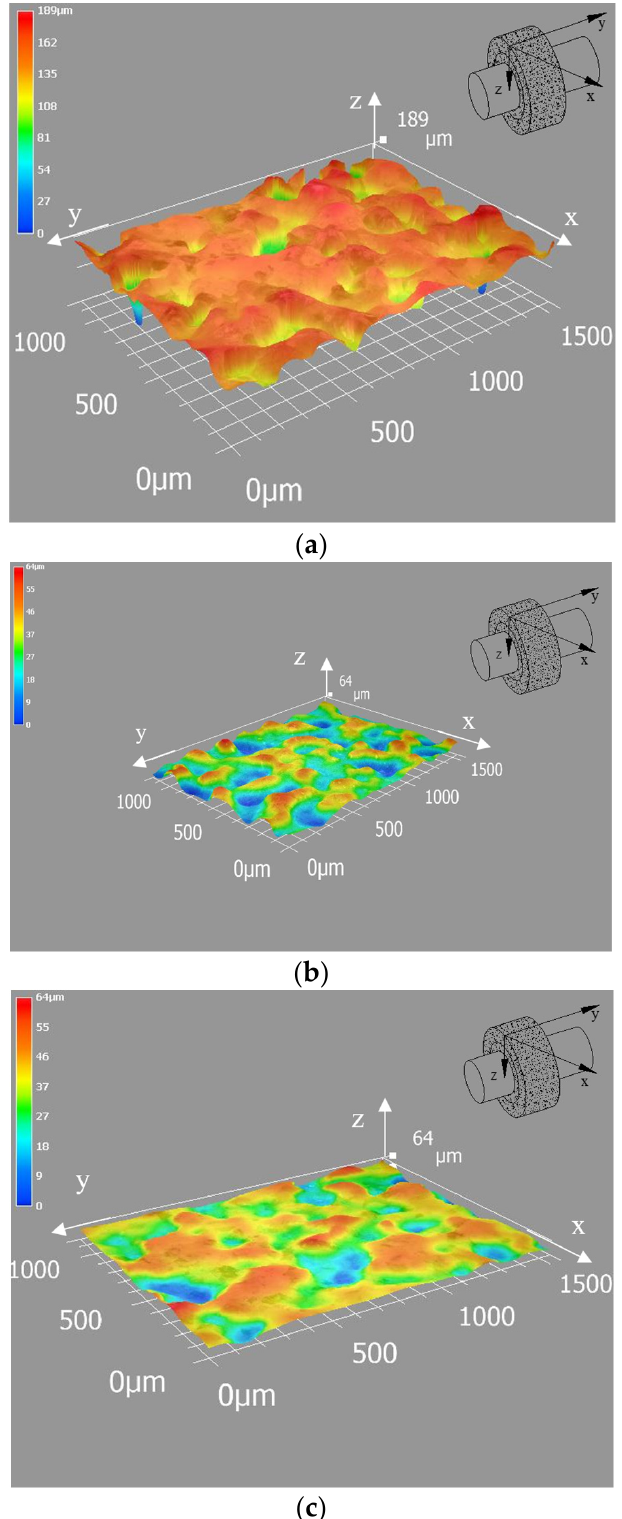
Figure 3. Wheel topography after dressing [40]. ( a ) After rough dressing; ( b ) after fine dressing; ( c ) after non-feeding dressing.